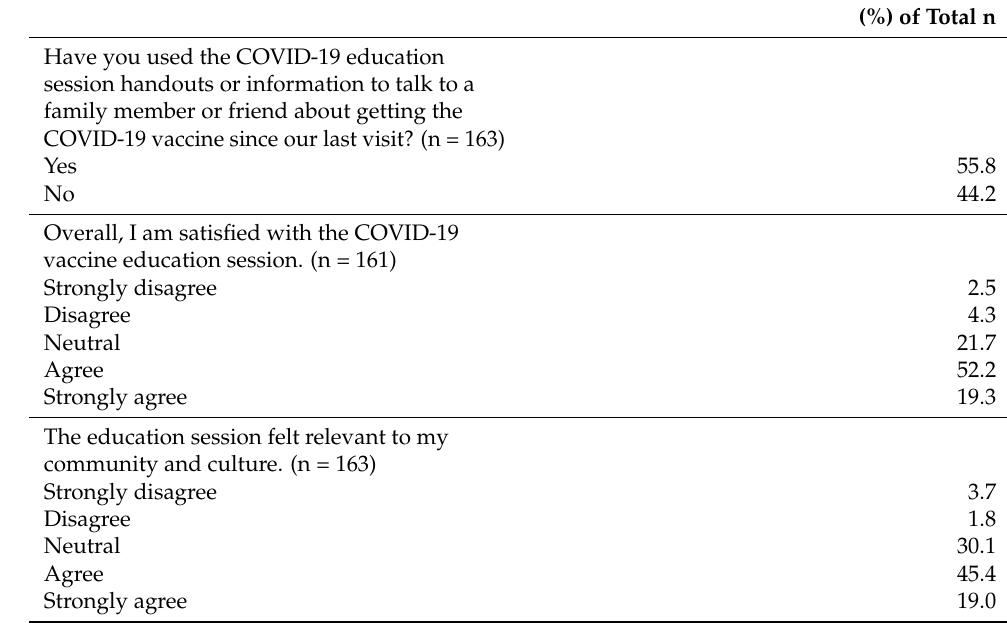
Table 5. Use of and satisfaction with COVID-19 education handouts and information at